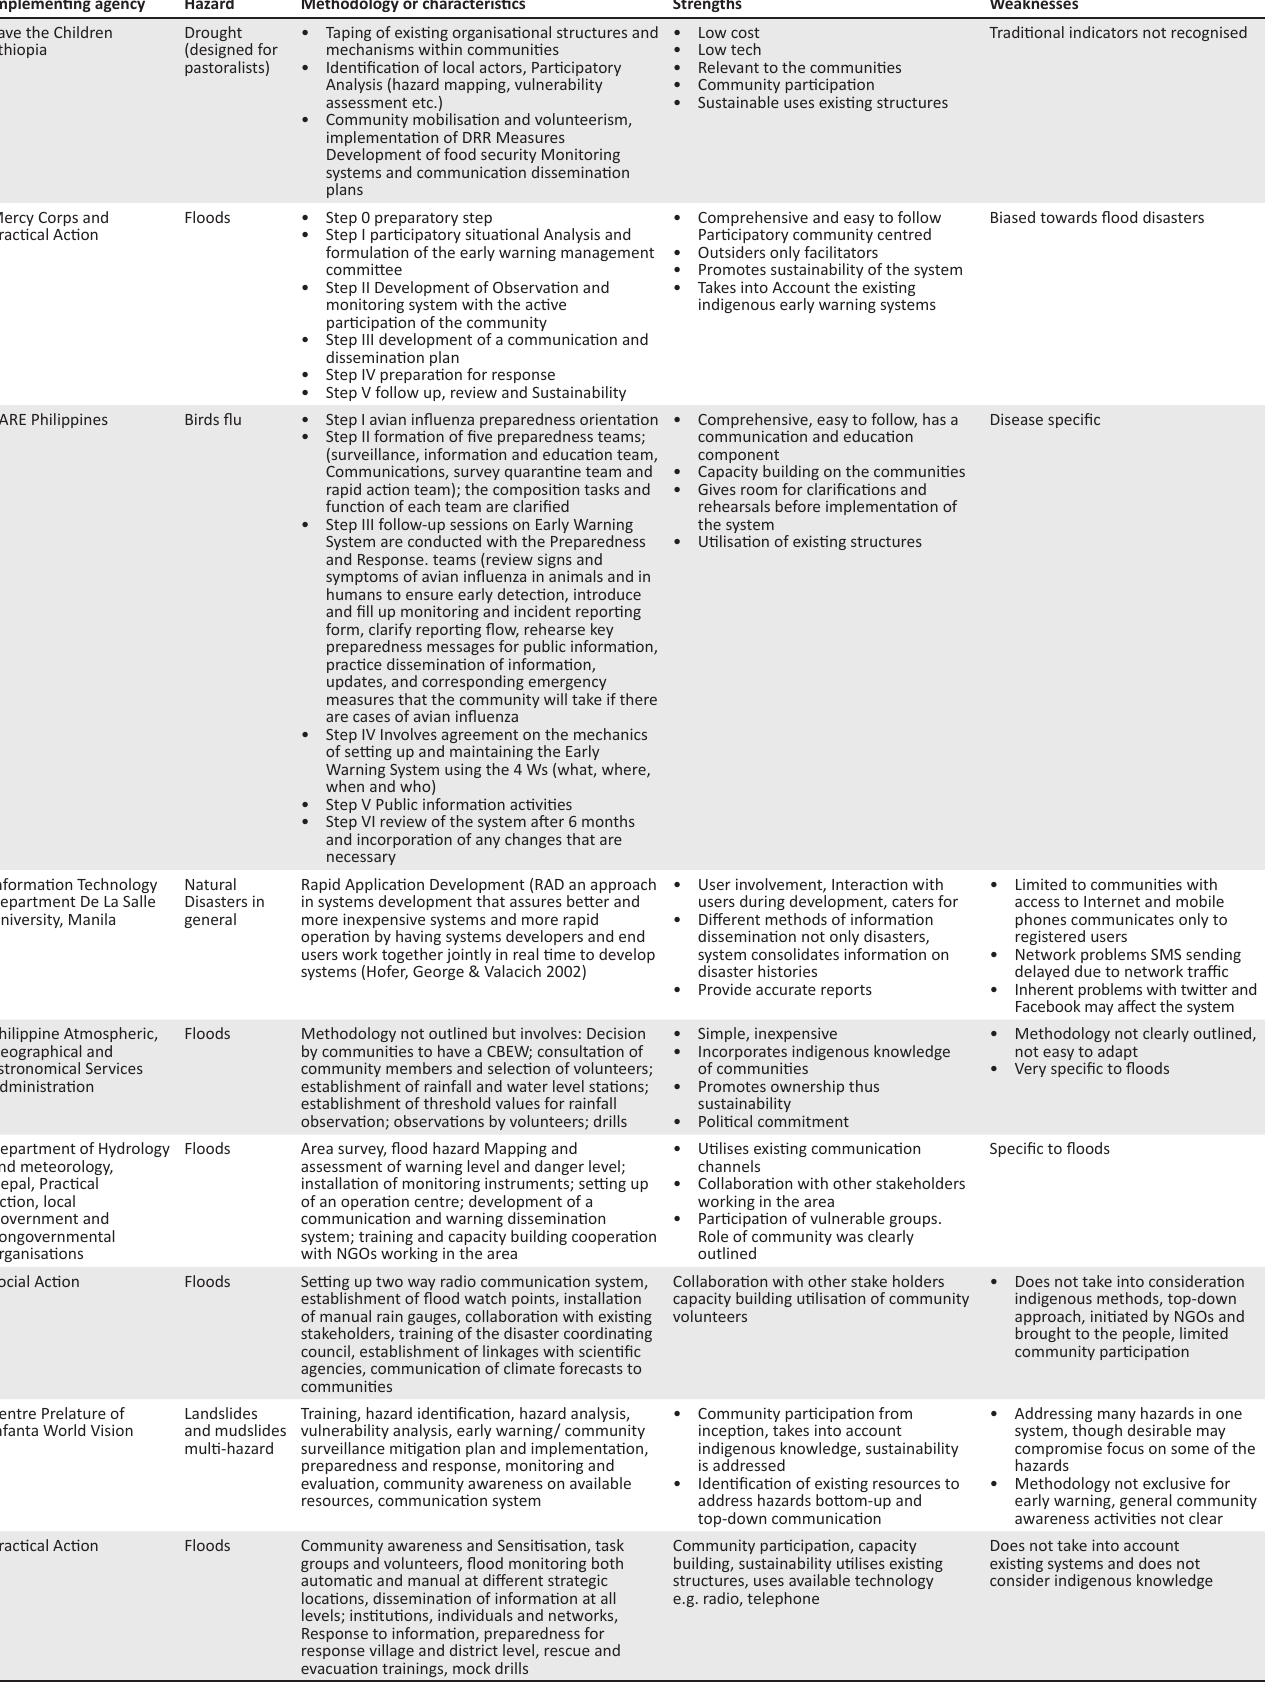
TABLE 2: Methodologies or characteristics of selected community based early warning